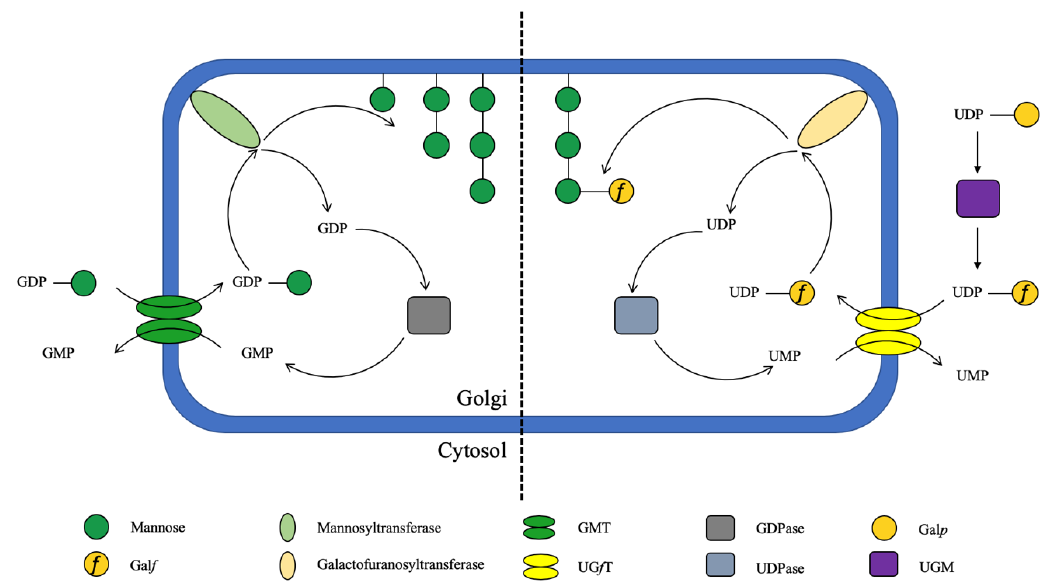
Figure 5. Schematic of the role of NSTs in the formation of mannans and galactomannans. See Figure 3 for chemical